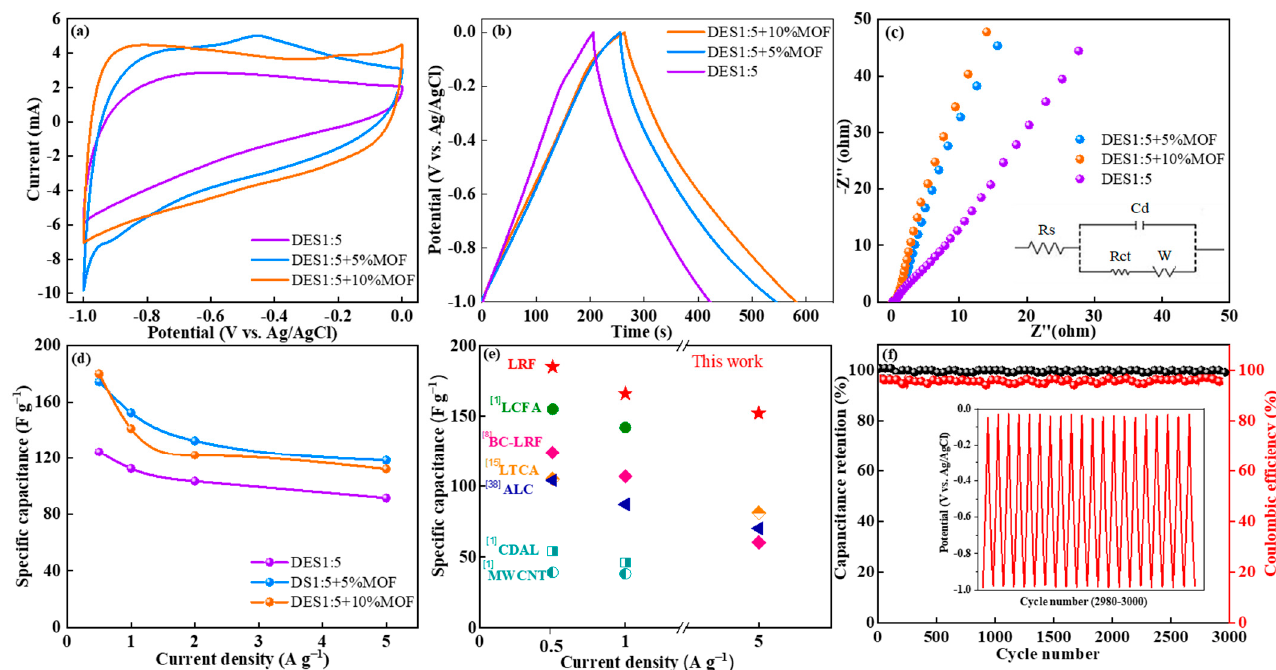
Figure 6. Electrochemical performances of the LRF carbon electrodes in 6 M KOH electrolyte: ( a , b ) representative CV and GCD curves; ( c ) Nyquist curves and the inset of equivalent circuit diagram; ( d , e ) mass-speci fi c capacitances; ( f ) cycling stability for 3000 cycles at 5 A g –1